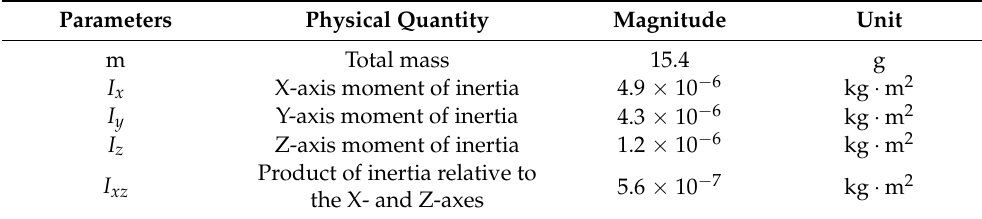
Table 1. Physical parameters of the CWMAV.